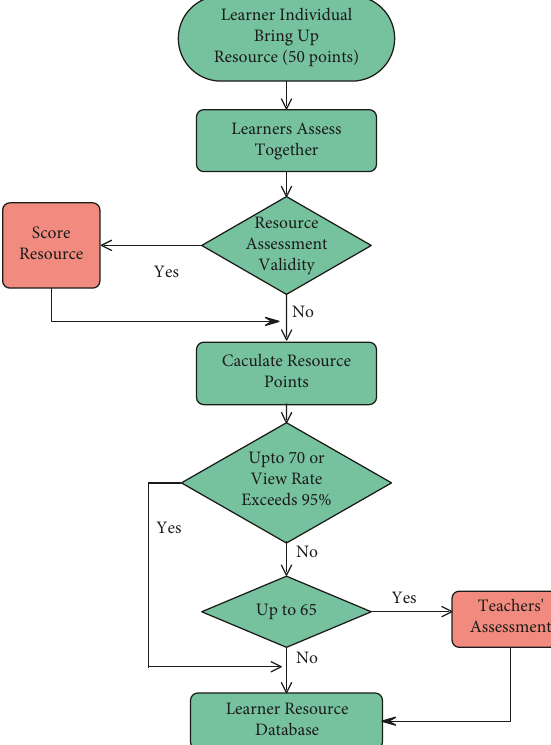
Figure 5: Flowchart of excellent resource evaluation.